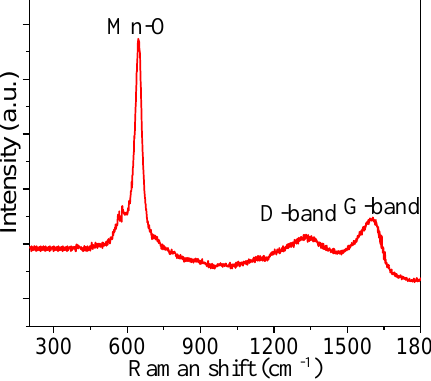
Figure 4. Raman spectrum of MnO 2 -NPs@CC.